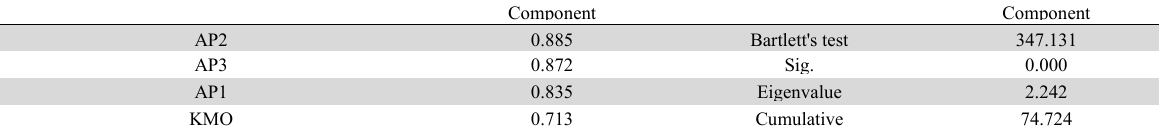
Correlation analysis results